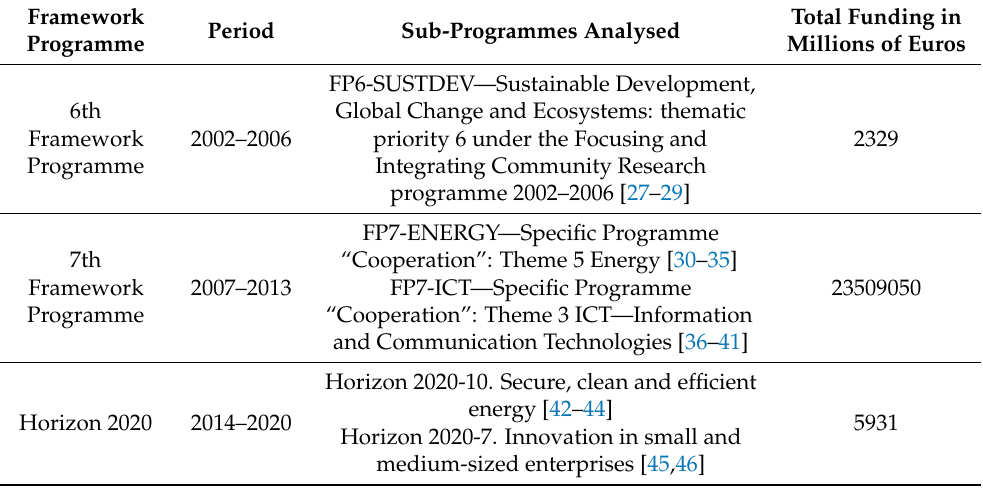
Table 2. European Framework Programmes and selected work programmes.